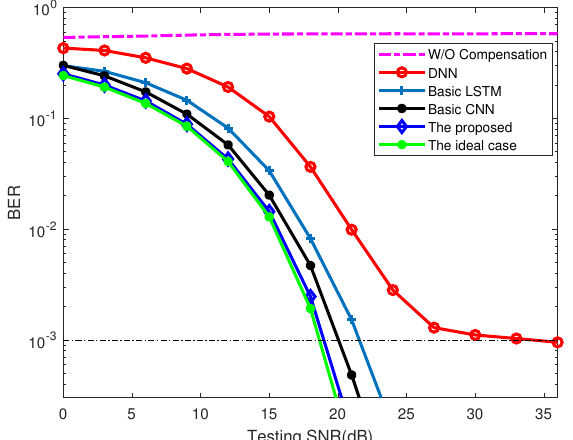
Figure 8. BER performance comparison of the proposed scheme and the other